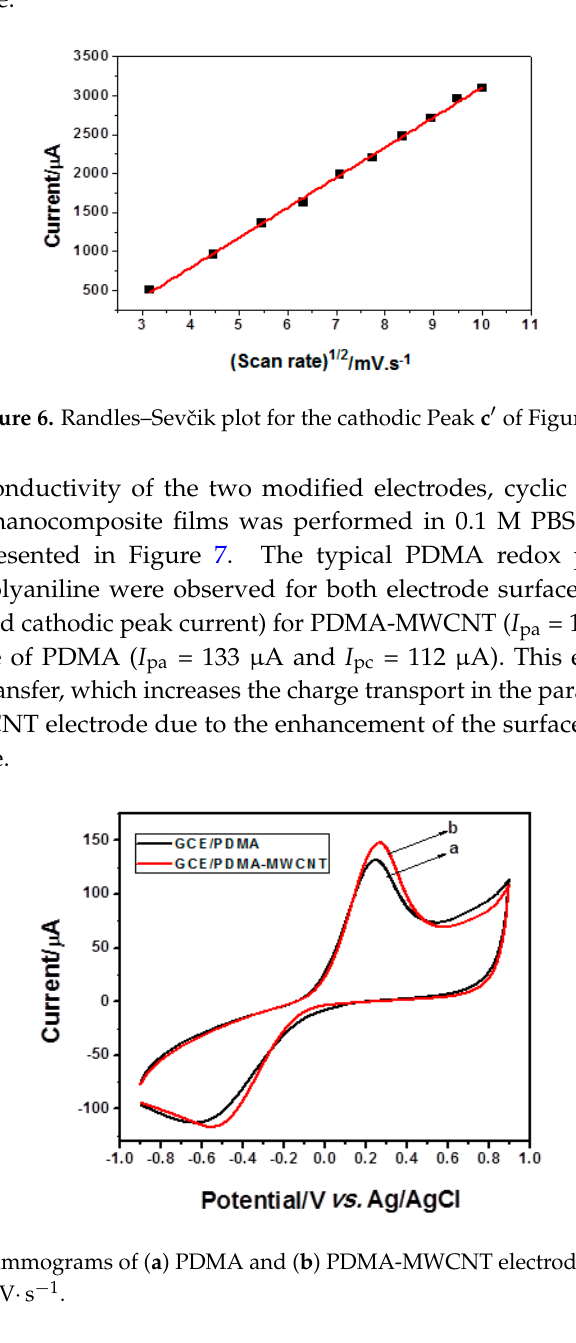
Figure 7. Cyclic voltammograms of ( a ) PDMA and ( b ) PDMA-MWCNT electrodes in 0.1 M phosphate buffer (PBS) at 100 mV·s − 1